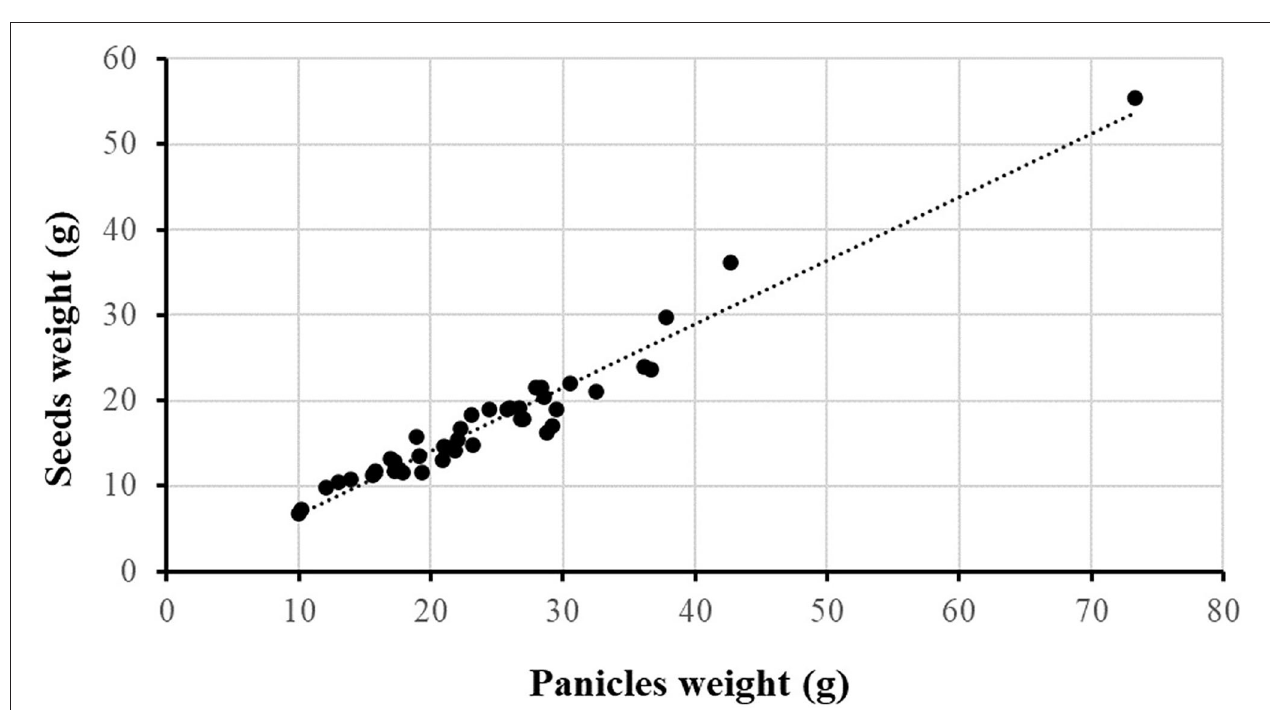
FIGURE 3 | Correlation between panicles and seeds dry weight evaluated with data collected in the last sampling of Exp2. Dashed line represents the linear regression of the data.